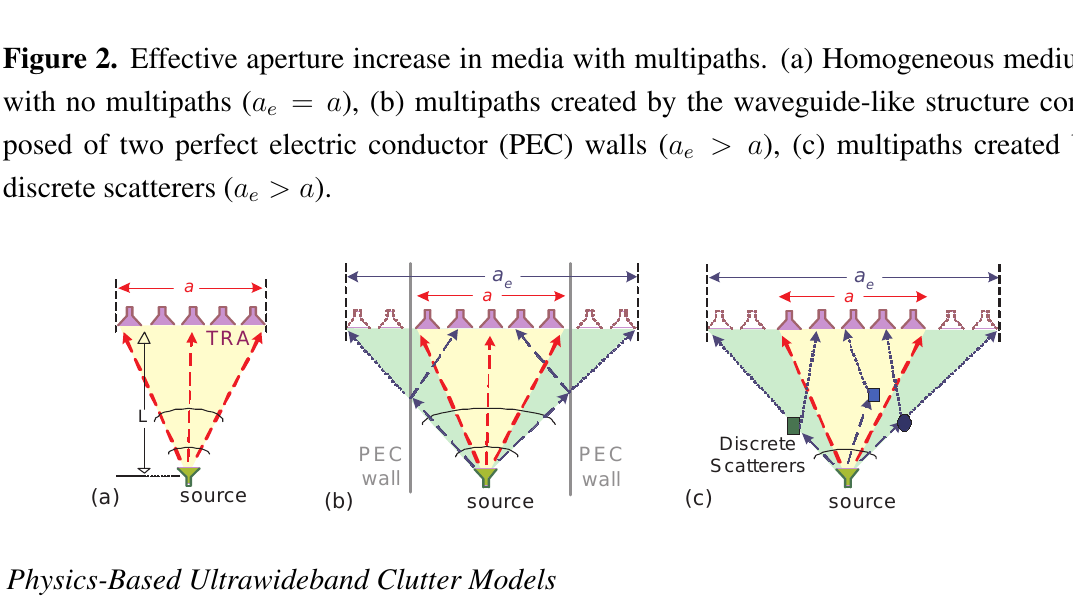
> a ), (c) multipaths created by e